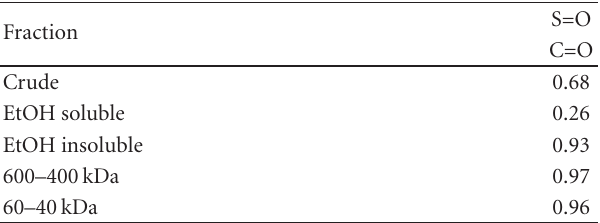
Table 2: Ratio of sulfate and carboxyl groups deduced from the FITR spectra of ulvan-containing fractions. Signals observed at 1256 and 1641 cm − 1 are caused by the stretching vibration of the S = O of sulfated rhamnose and of the C = O of uronic acid,